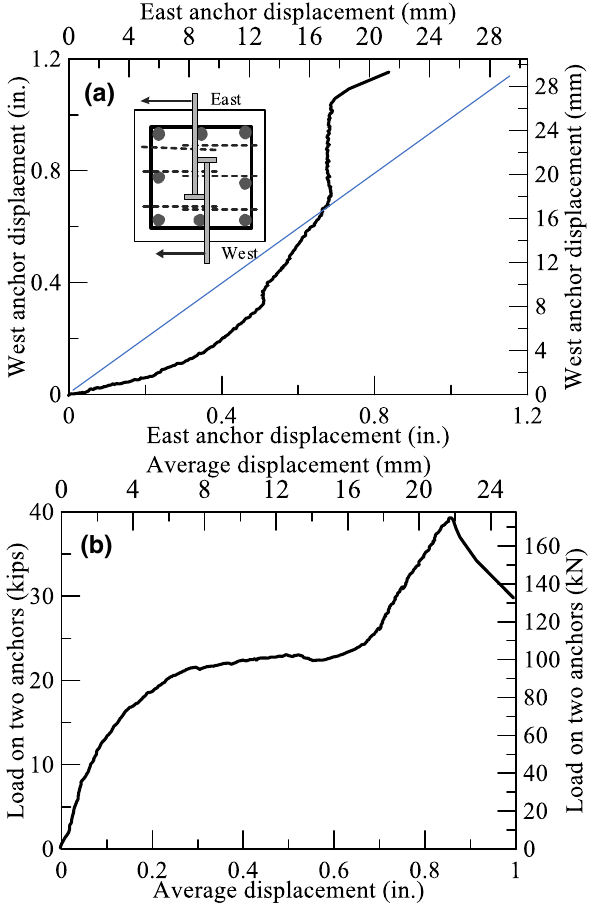
Fig. 9 Behavior of single anchor in plastic hinge zone under cyclic shear loading. a load vs anchor displacement measured by LVDT’s and b load vs anchor displace- ment measured by